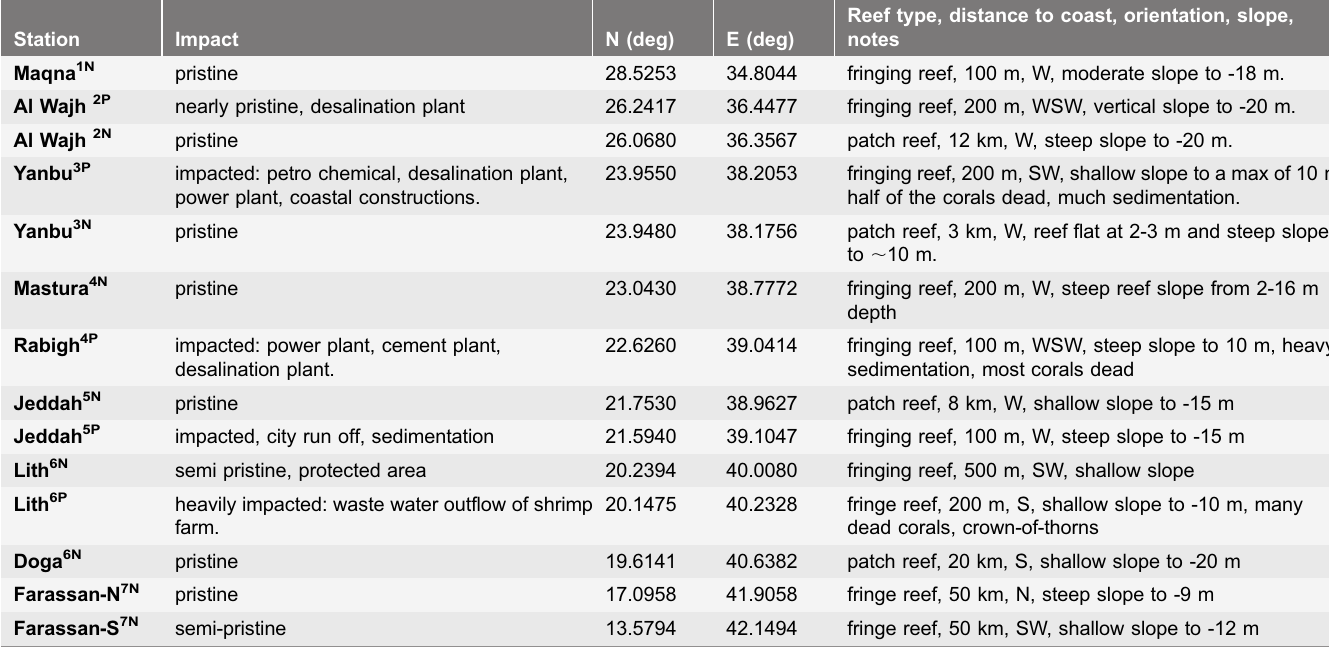
Table 1. Investigated sites along the Saudi Red Sea